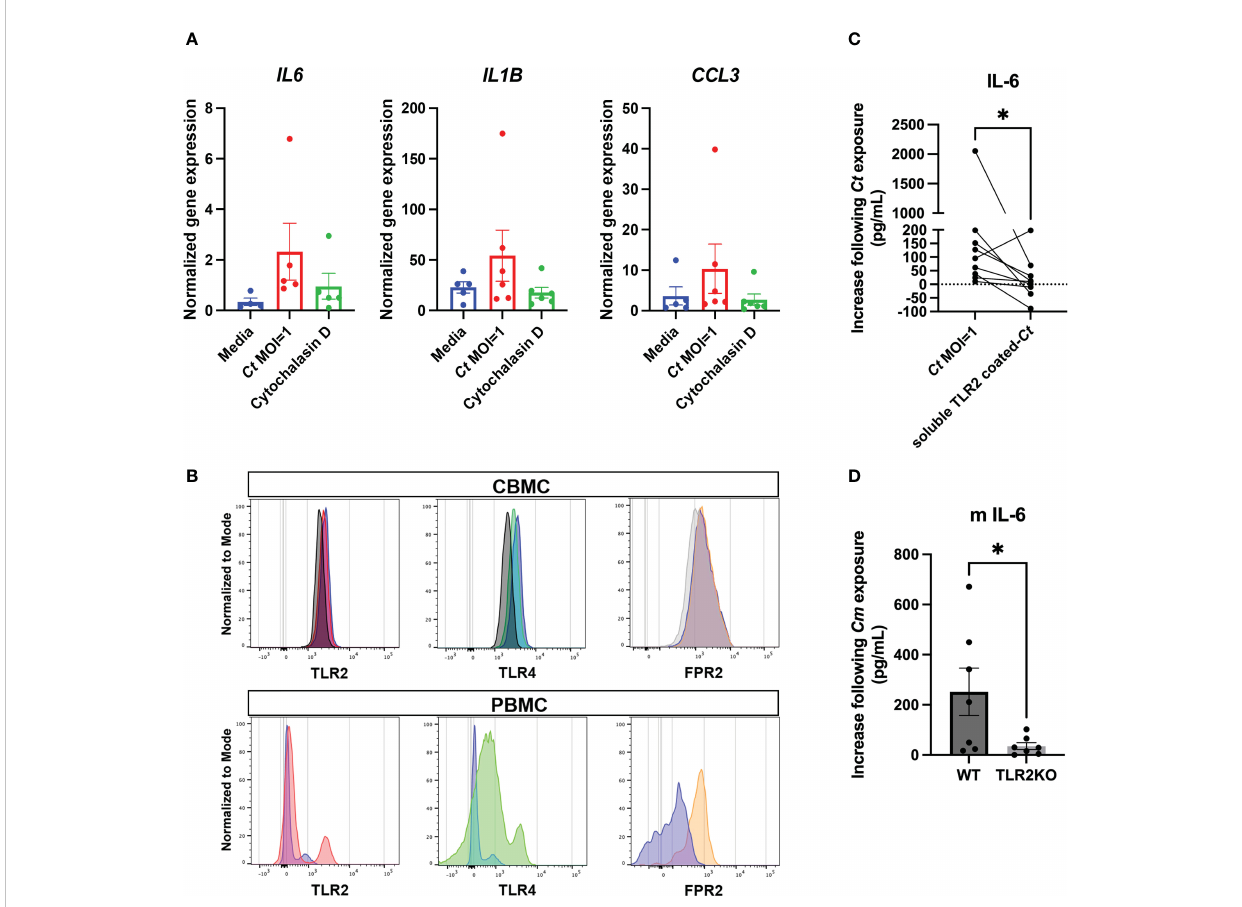
FIGURE 5 Mast cell C. trachomatis interaction occurs at both the surface and intracellular levels by mechanisms that include TLR2-dependent pathways. CBMCs treated with the endocytosis inhibitor cytochalasin D (1.25 µg/ml) prior to C. trachomatis exposure were analyzed for IL6 , IL1B , and CCL3 gene expression (A) . Data represents n = 6 donors from two independent experiments and are graphed as mean ± SEM. Surface and/or intracellular expression of pattern recognition receptors TLR2, TLR4, and FPR2 was determined by fl ow cytometry (B) . CD117+ CBMCs were gated after the selection of single and live cells, and TLR2, TLR4, and FPR2 expression on C. trachomatis- treated versus control mast cells were analyzed by histogram overlays on isotype controls or FMO controls. Shown are example histograms of TLR2, TLR4, and FPR2 expression in C. trachomatis - treated CBMCs, shown in red, green, and orange colors, respectively. Medium-only controls are shown in violet color, and isotype or FMO